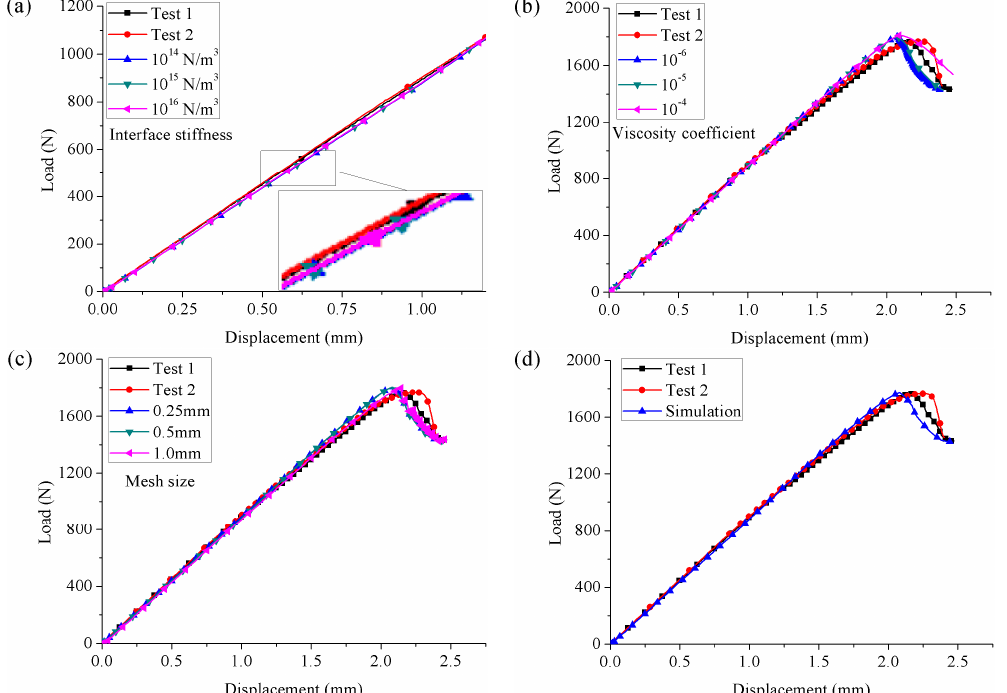
Figure 10. Influence of ( a ) interface stiffness, ( b ) viscosity coefficient, ( c ) mesh size on the predicted load–displacement response and ( d ) numerical results of the ENF test at 80 °C.